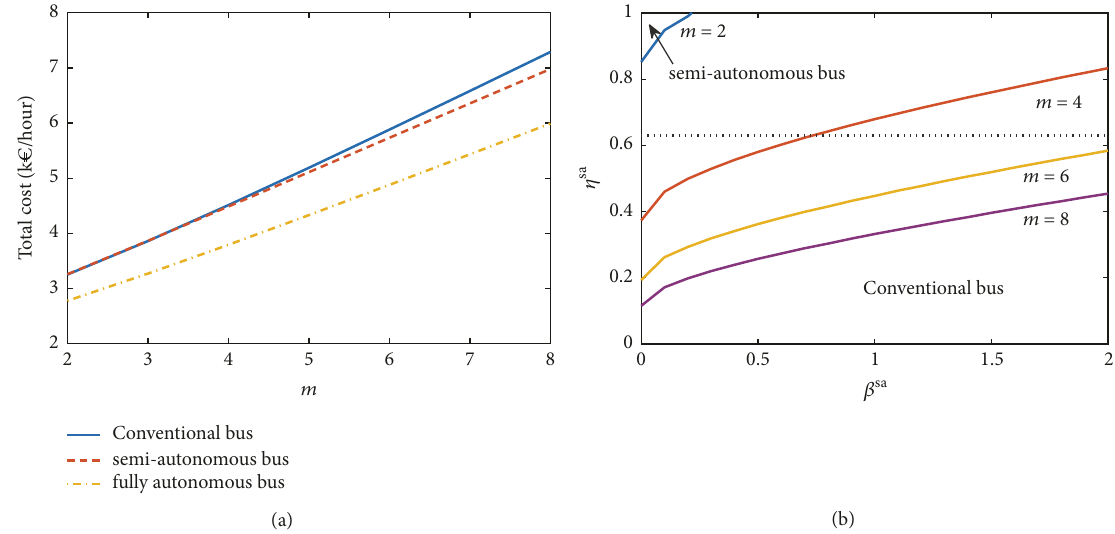
Figure 6: (a) Total cost and (b) applicability of semi-autonomous buses with respect to different 𝑚 . Note that the top-left side of each curve in (b) indicates the preferable region of semi-autonomous buses, whereas the other side is for conventional buses. The dotted line gives the upper bound of 𝜂 sa , which is 0.63. Other parameters according to Table